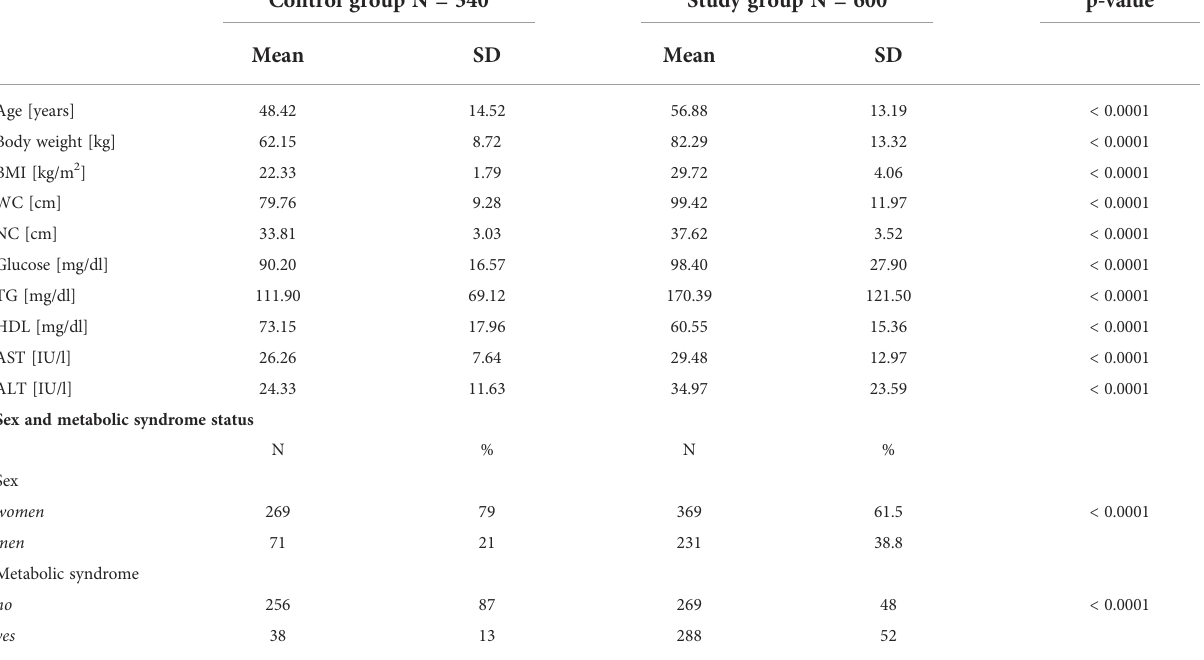
TABLE 1 The characteristics of the study